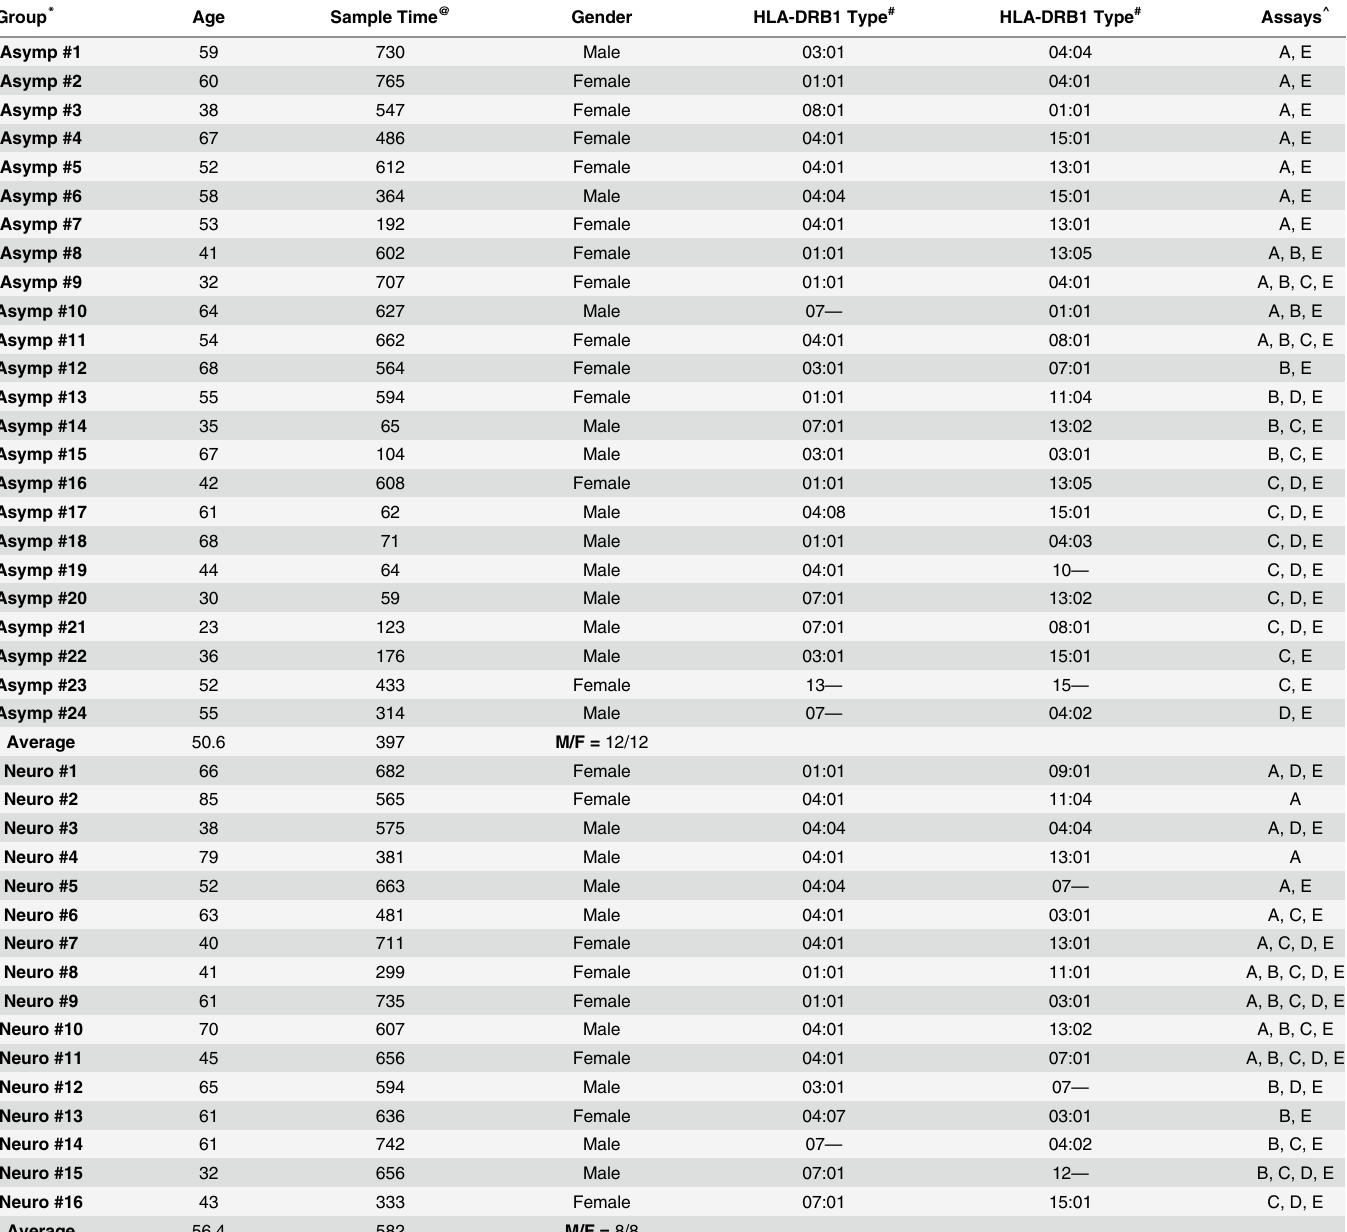
Table 1. Characteristics of WNV infected